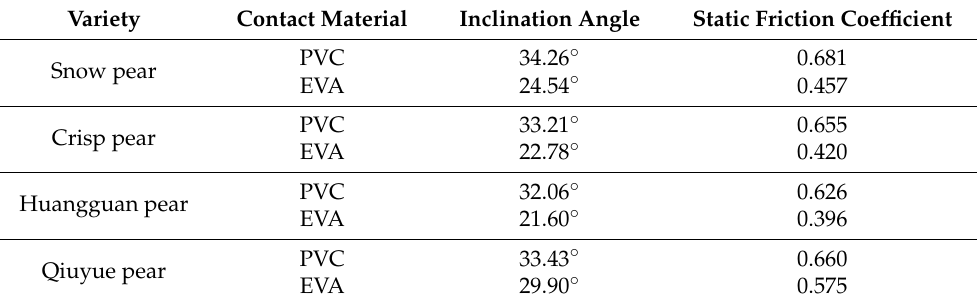
Table 6. Measured values of static friction coefficient between typical pears and materials. Variety Contact Material